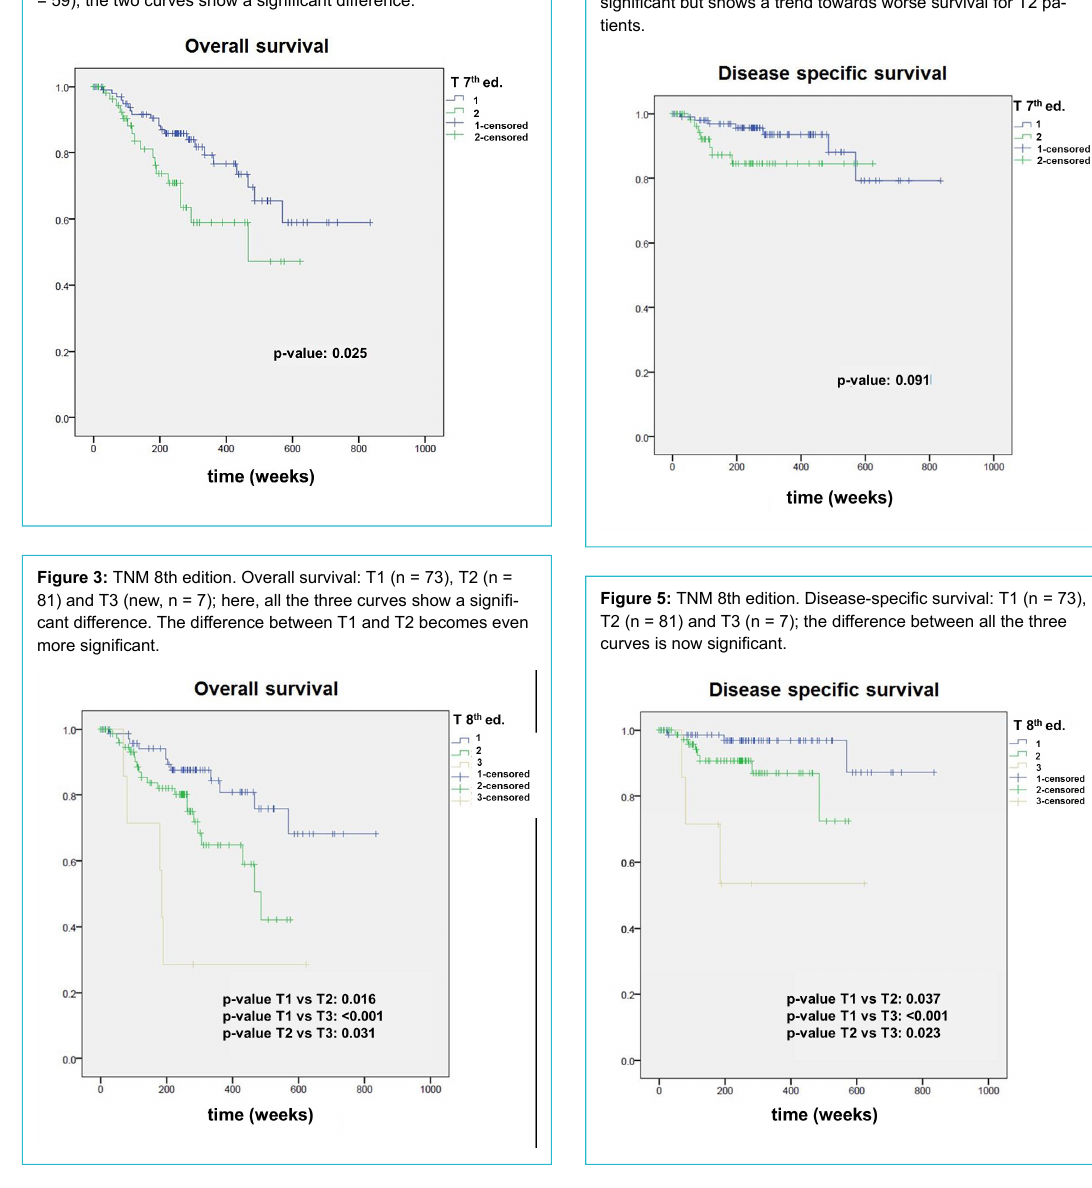
Figure 2: TNM 7th edition. Overall survival: T1 (n = 102) and T2 (n = 59); the two curves show a significant difference.